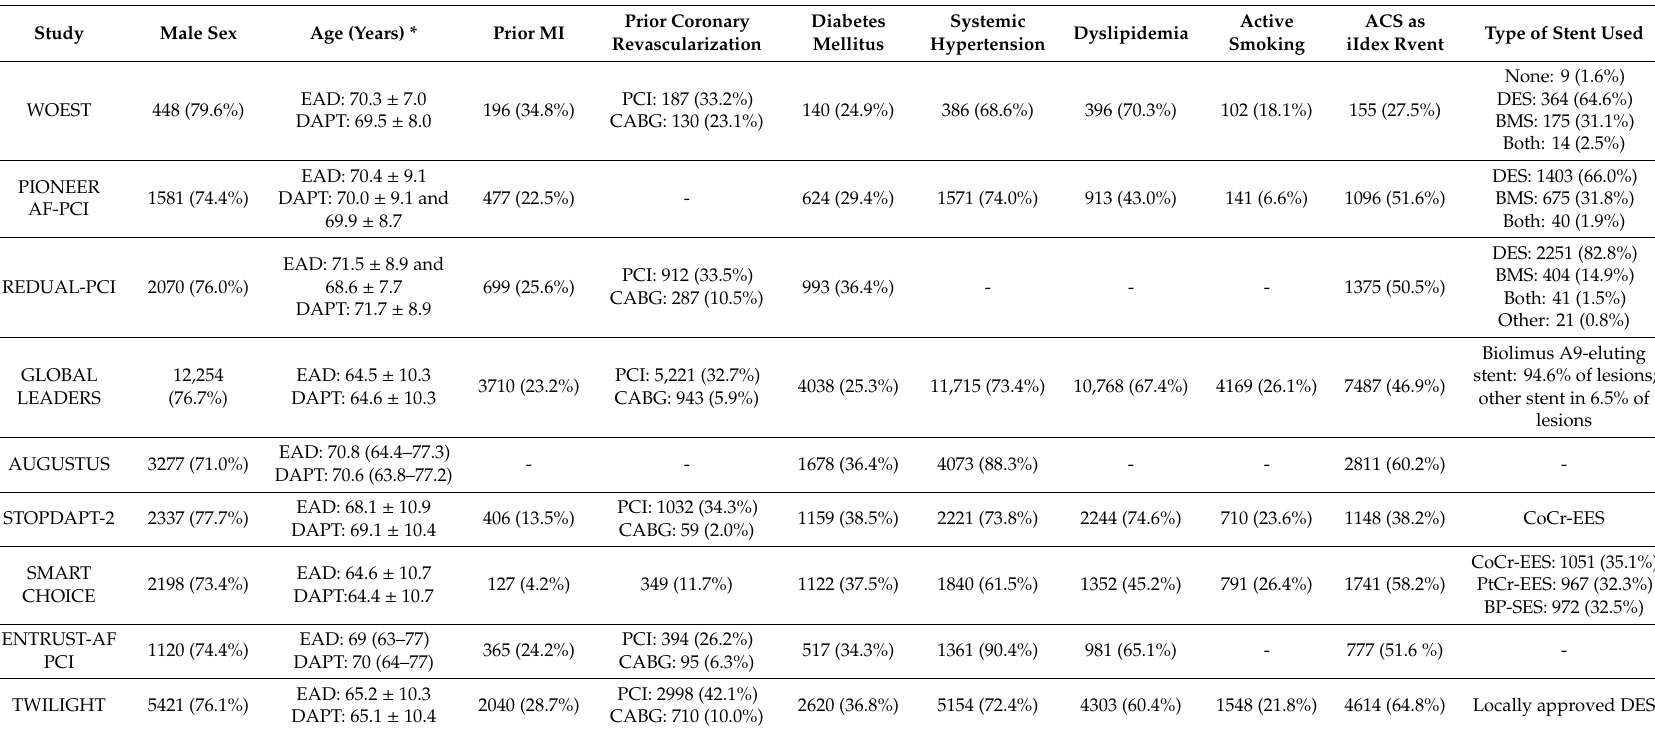
Table 2. Baseline patients’